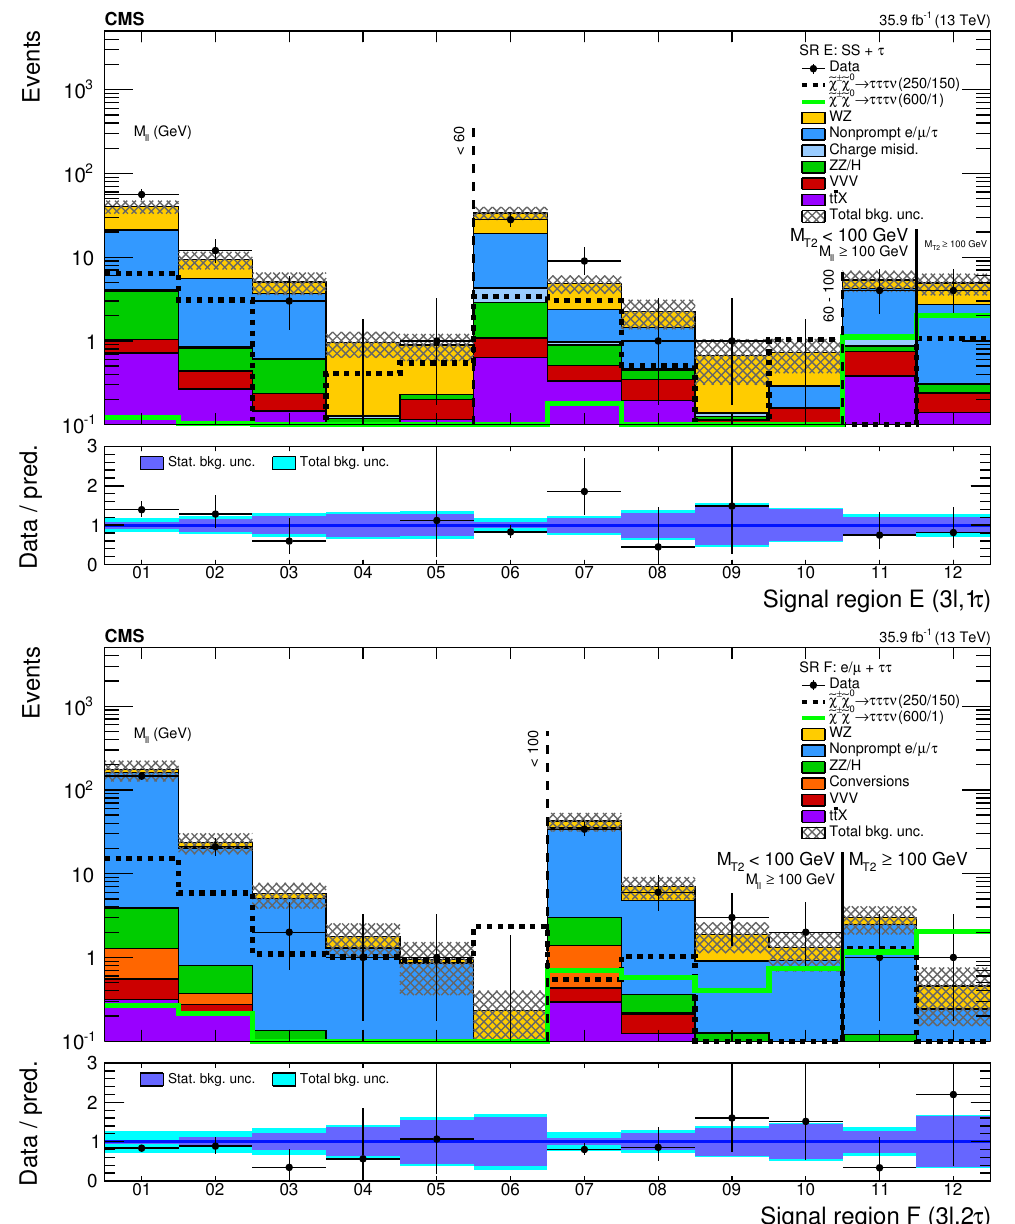
Figure 11 . Expected and observed yields comparison in events with one (cid:28) and in events with two (cid:28) h : category F (lower). Two signal mass points in the (cid:28) -dominated model with mass parameter x = 0 : 5 are displayed for illustration. The notation is analogous to that used in (cid:12)gure